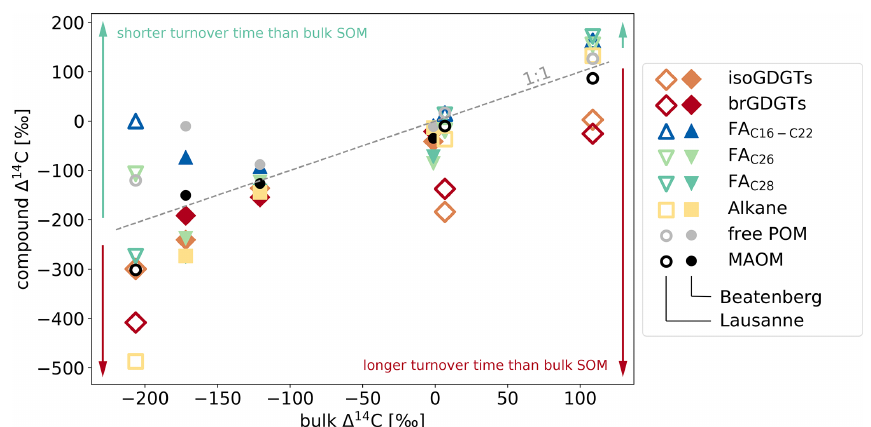
Figure 5. Relationship between (cid:49) 14 C values of specific components and bulk SOM in Beatenberg and Lausanne soil profiles. The different analyzed compounds and density fractions (Van der Voort et al., 2017) cover a greater range of (cid:49) 14 C values with soil depth, as reflected in the aging of the bulk OC in the respective soil. The dotted line represents equal compound and bulk (cid:49) 14 C. Two groups are discernable, namely those with (cid:49) 14 C values higher than the bulk OC, and thus with a more rapid turnover (in most samples, this includes short-chain, i.e., C 16 –C 22 , FA and the low density fraction or free POM), and those with lower (cid:49) 14 C values, implying longer turnover times (including long-chain n -alkanes, i.e., in the Beatenberg soil C 29 -alkane and in the Lausanne soil the C 27 ), and fatty acids, i.e., C 26 , C 28 FA, and the GDGTs. Table 2. Soil properties related to the stability of soil organic matter. Effective cation exchange capacity (CEC), Fe d (dithionite-extractable iron), Fe o and Al o (oxalate-extractable iron and aluminum), Fe p and Al p (pyrophosphate-extractable iron and aluminum) as well as sand, silt and clay content are provided by Zimmermann et al. (2006). Note: ppm – parts per million. CEC Fe d Fe o Fe p Loc Depth (mmolCkg − 1 )